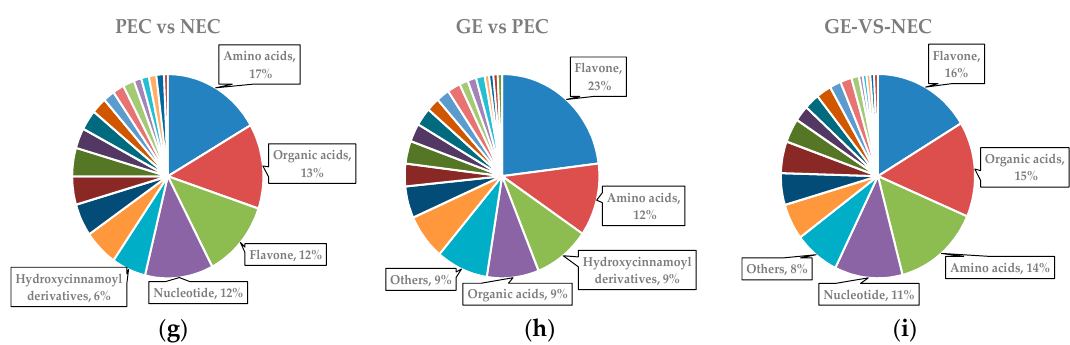
Figure 4. Differentially accumulated metabolites (DAMs) among NEC, PEC, and GE. ( a ) Volcano plot showing the differential metabolites in PEC vs. NEC; ( b ) volcano plot showing the differential metabolites in GE vs. PEC; ( c ) volcano plot showing the differential metabolites in GE vs. NEC. The red spots represent upregulated DAMs, the green dots represent downregulated DAMs, and the black dots represent nondifferentially accumulated metabolites; ( d ) Heat map representing the hierarchical cluster analysis in PEC vs. NEC; ( e ) heat map representing the hierarchical cluster analysis in GE vs. PEC; ( f ) heat map representing the hierarchical cluster analysis in GE vs. NEC. Red indicates high abundance, whereas the relatively low-abundance metabolites are shown in green; ( g ) component analysis of DAMs in PEC vs. NEC; ( h ) component analysis of DAMs in GE vs. PEC; ( i ) component analysis of DAMs in GE vs. NEC. The top five DAMs are noted beside each graph. NEC, nonembryogenic staged calli; PEC, primary embryogenic calli; GE, initiation staged embryos with globular-like enriched.